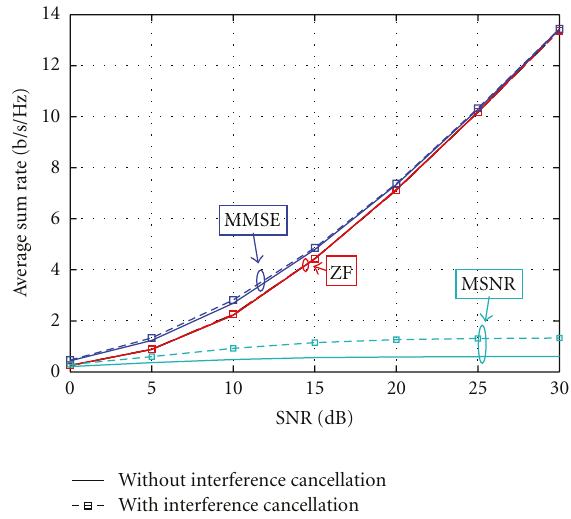
Figure 3: Sum rate performance of three-way relaying for multi- plexing transmission with SMTB and symmetric tra ffi c.